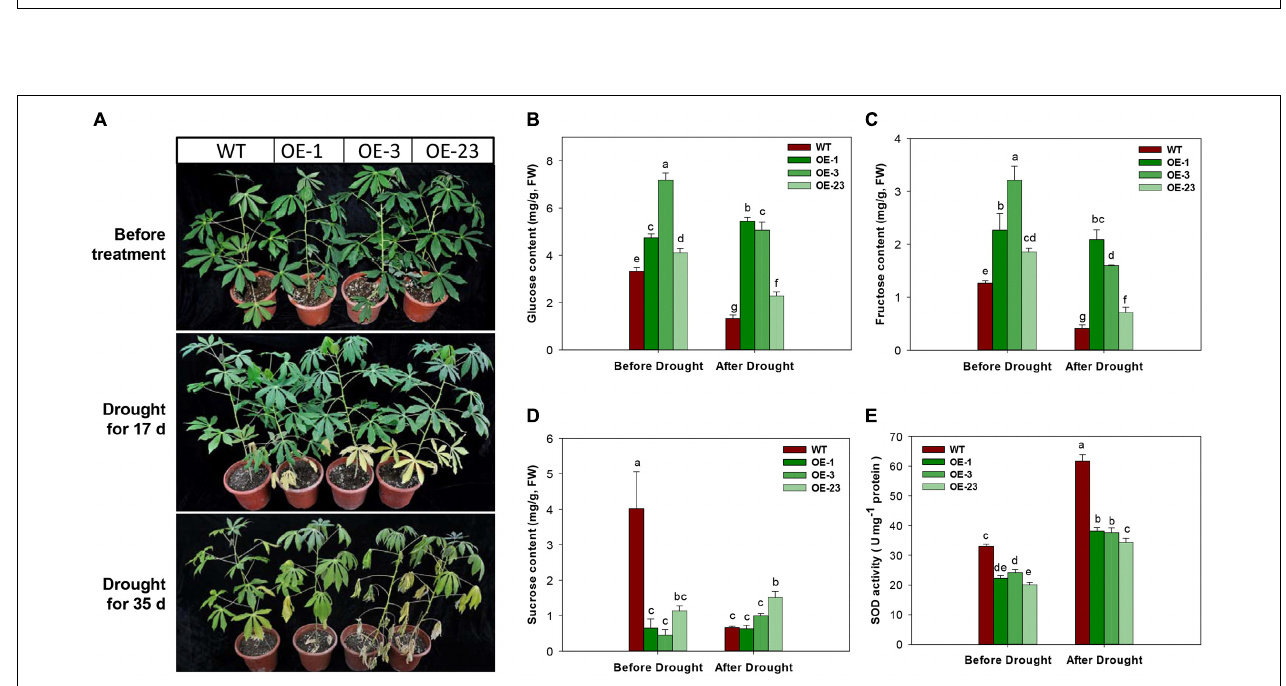
FIGURE 10 | Phenotypical and physiological performance of wild-type (WT) and MeCWINV3 -overexpressed (OE) cassava plants under drought treatment. (A) Changes in plant phenotype under drought treatment for 17 and 35 days. (B–D) Contents of glucose (B) , fructose (C) , and sucrose (D) in mature leaves. (E) Total SOD activity in mature leaves. Different letters indicate significant differences (one-way ANOVA, p < 0.05).